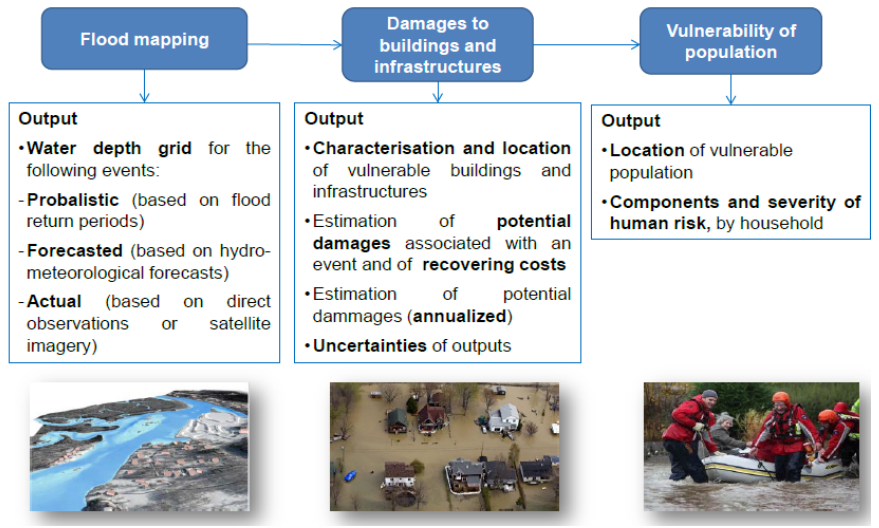
Figure 2. Output information for all three modules of the GARI tool.